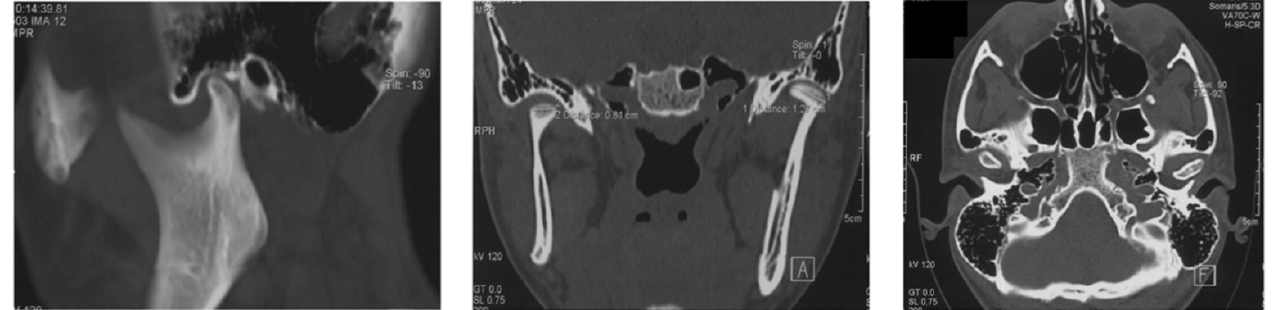
Figure 2. A 7-year-old female patient, affected by oligoarticular form ANA+, RF − , with age of onset 5 years. Joints involved in the onset: right knee and duration of the disease until gnathological evaluation: 9 years in systemic therapy with methotrexate. At the anamnesis, she did not show any previous therapy concerning TMJs and orthodontic treatments. The patient presented a unilateral right tumefaction at the clinical examination, a bilateral temporomandibular click, and the mandibular deviation (to the right).